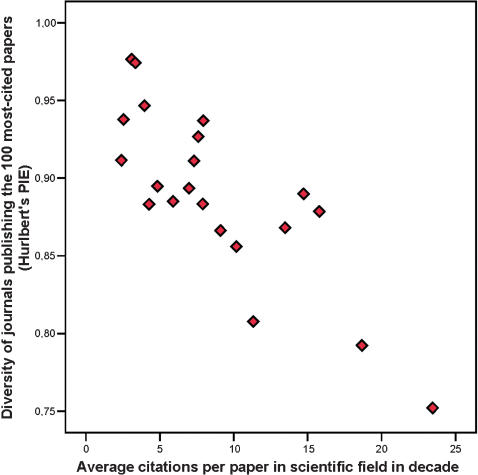
The diversity of journals publishing the 100 most-cited papers in a scientific field (here expressed by Hurlbert's PIE) is negatively related with the average number of citations per paper in the field (citation density).